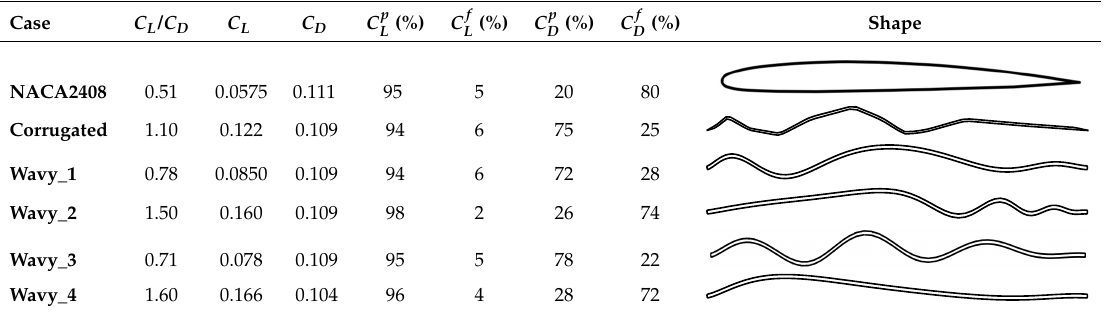
Table 3. The time-averaged aerodynamic coefficients and its breakdown for the pressure and friction stress contributions of the various geometries at Re = 10 3 and α = 0 ◦ . The superscripts p and f denote the pressure and friction stress components,